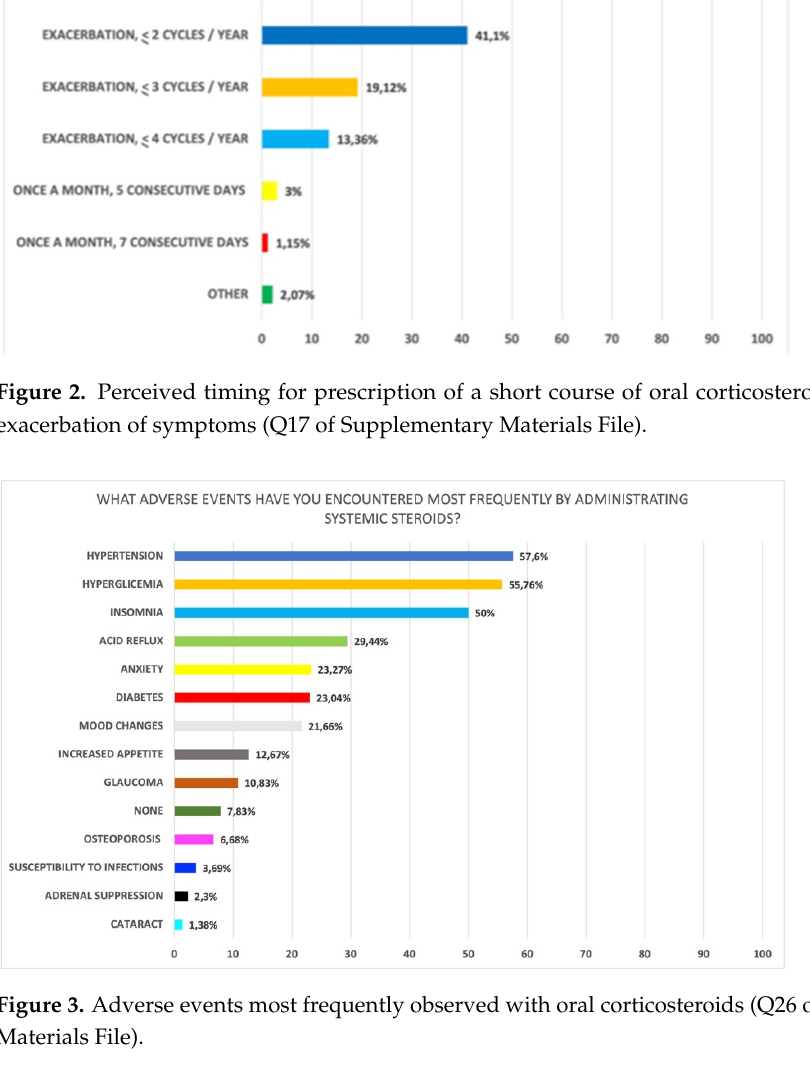
Figure 3. Adverse events most frequently observed with oral corticosteroids (Q26 of Supplementary Materials File).